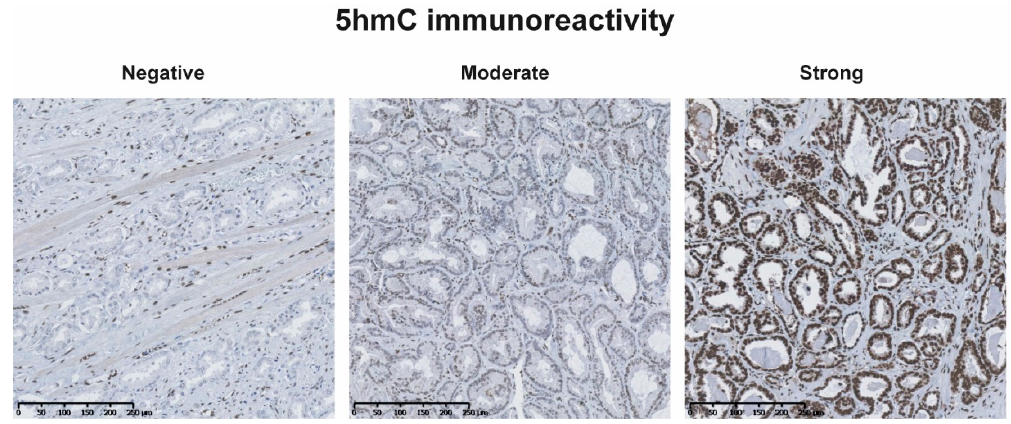
Figure 4. IHC 5hmC staining in representative prostate cancer samples showing negative, moderate and strong